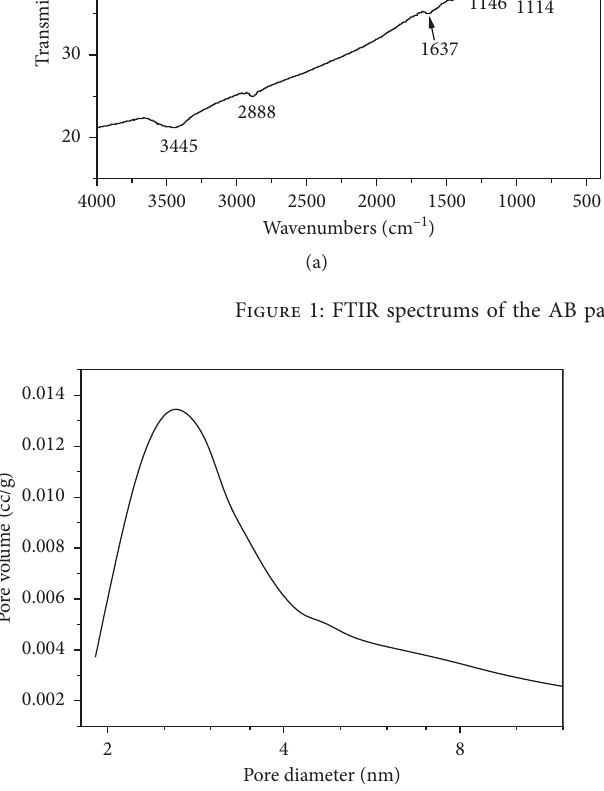
Figure 2: Pore-size distribution of the AB